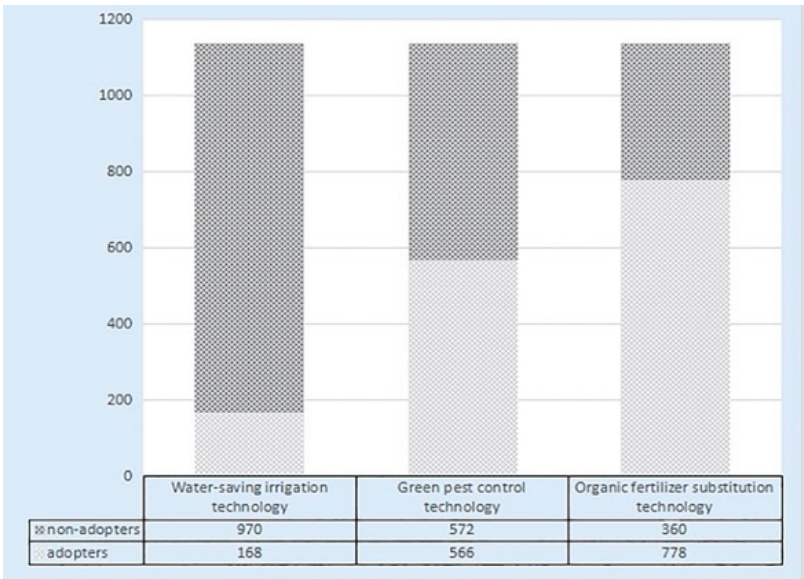
Figure 4. Statistics of farmers’ adoption of agricultural green production.